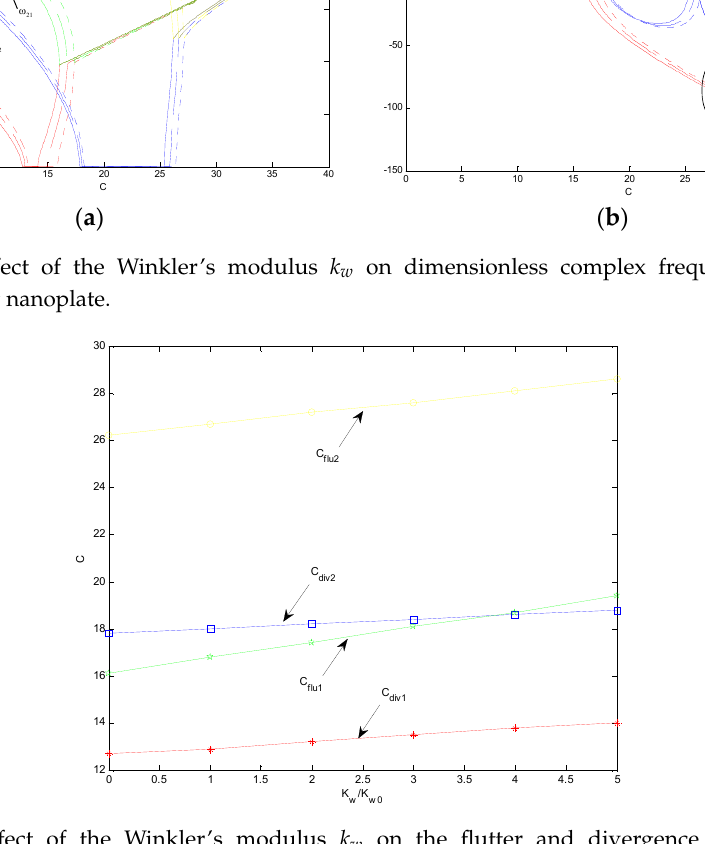
( b ) Figure 7. Effect of the Pasternak’s modulus k G on dimensionless complex frequencies of the axially-moving nanoplate.